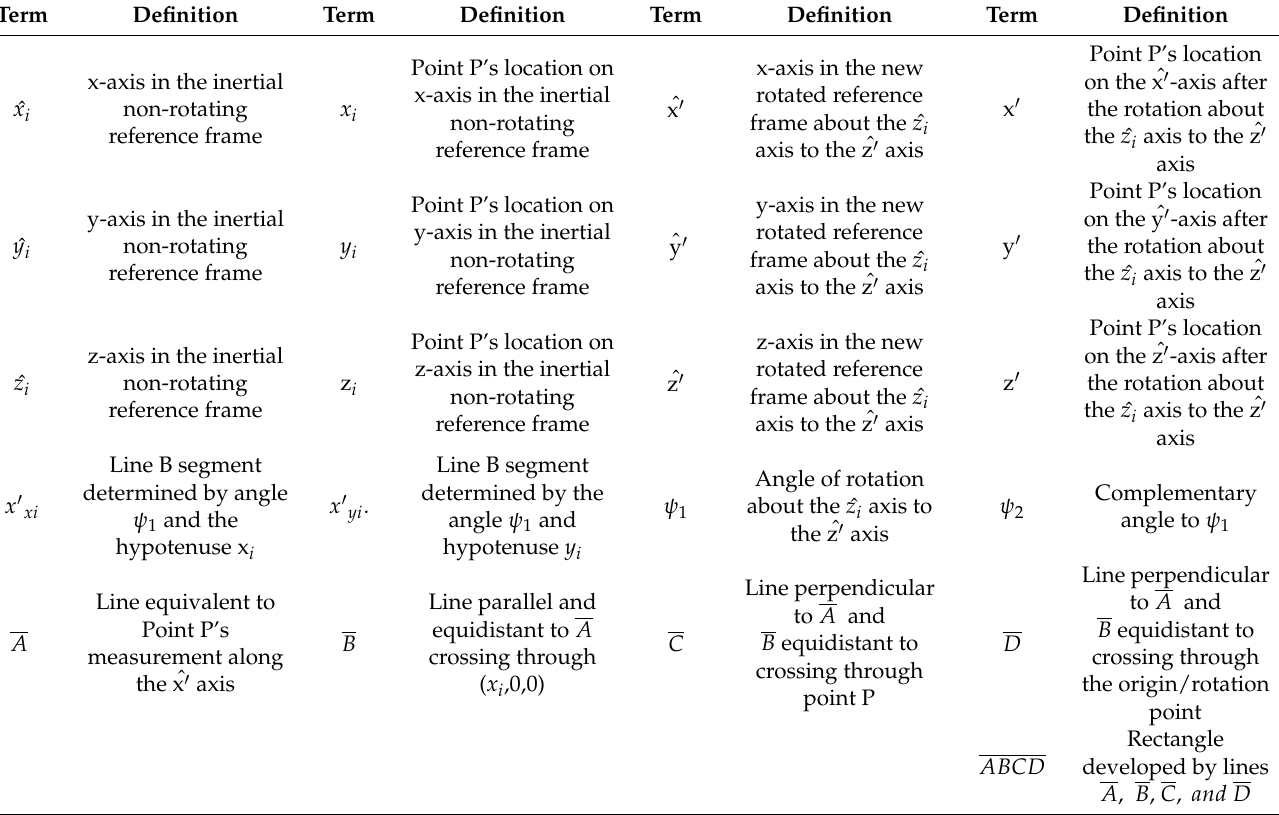
Figure 7. ( a ) Point P is dropped within the inertial orientation to develop the direction cosine matrix; ( b ) 3-rotation about the 𝑧 𝑖 ̂ and 𝑧′̂ axes to develop P’s coordinates in the new reference frame. Table 2. Proximal variable and nomenclature definitions for Figures 7 – 12.